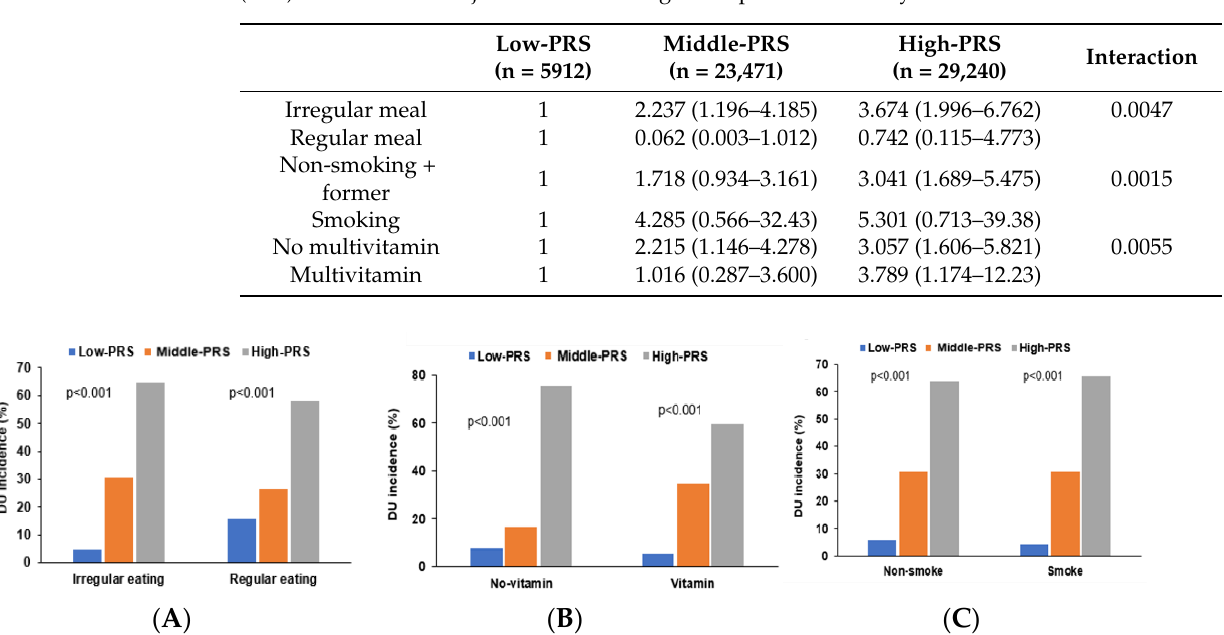
Figure 6. Percentage of the participants with duodenal ulcers according to polygenic risk scores (PRS) in different lifestyles. ( A ) Irregular meal eating. ( B ) Taking multivitamins. ( C ) Smoking status. The polygenic risk score (PRS) for the best model was generated by summing the number of the risk alleles in each selected genetic variant with the gene-gene interaction model. The PRS of the model was divided into three categories as Low-PRS (PRS < 4), Middle-PRS (PRS = 4 and 5), and High-PRS (PRS > 5). The adjustment with covariates of age, gender, education, income, residence area, energy intake, alcohol intake,